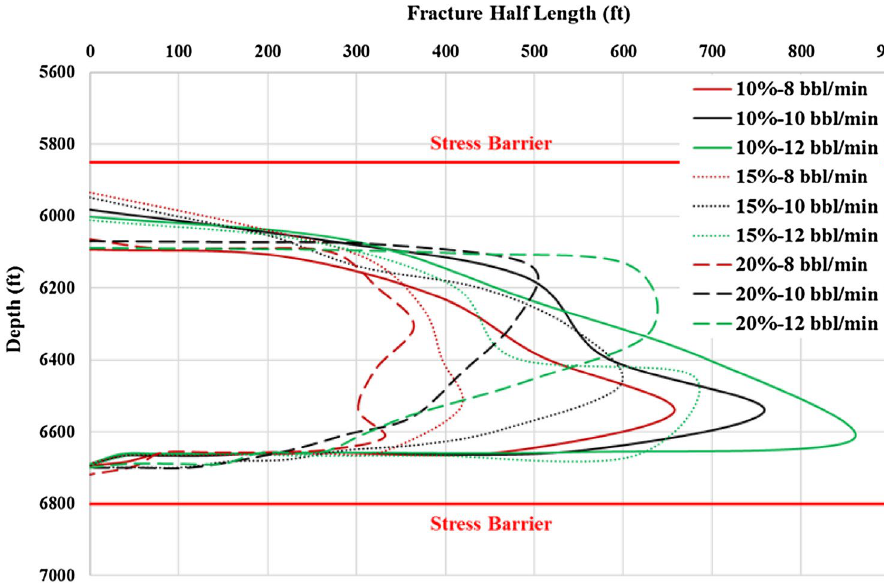
Fig. 7 User interface of the web application for 3D fracture simulation. Fracture simulations can be conducted before or during any injection under real injection condition, which provides valuable information about fracture geometry and it sensitivity to each injection parameter Fig. 8 Geometry of